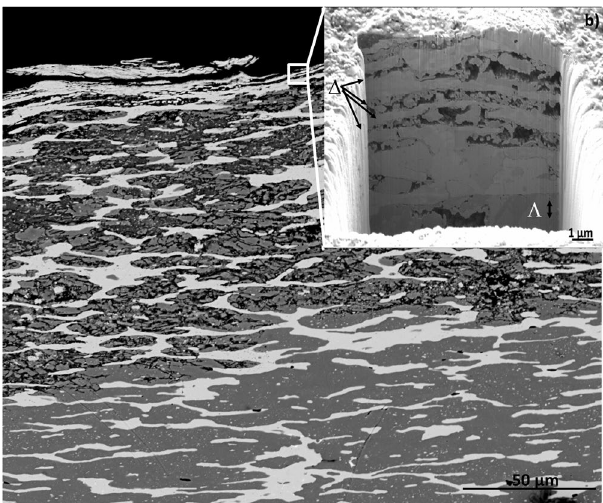
Figure 5. Combined image of ( a ) BSE of coin G and ( b ) a focus on a smaller area where a trench was done using FIB-FESEM. The images highlight the corrosion process and the progressive depletion of Cu as evidenced by the occurrence of secondary pores. Trench image width 18.5 μ